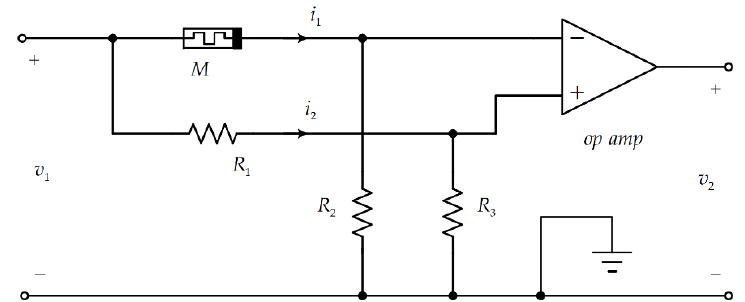
Figure 8. A schematic of the used memristor synapse.